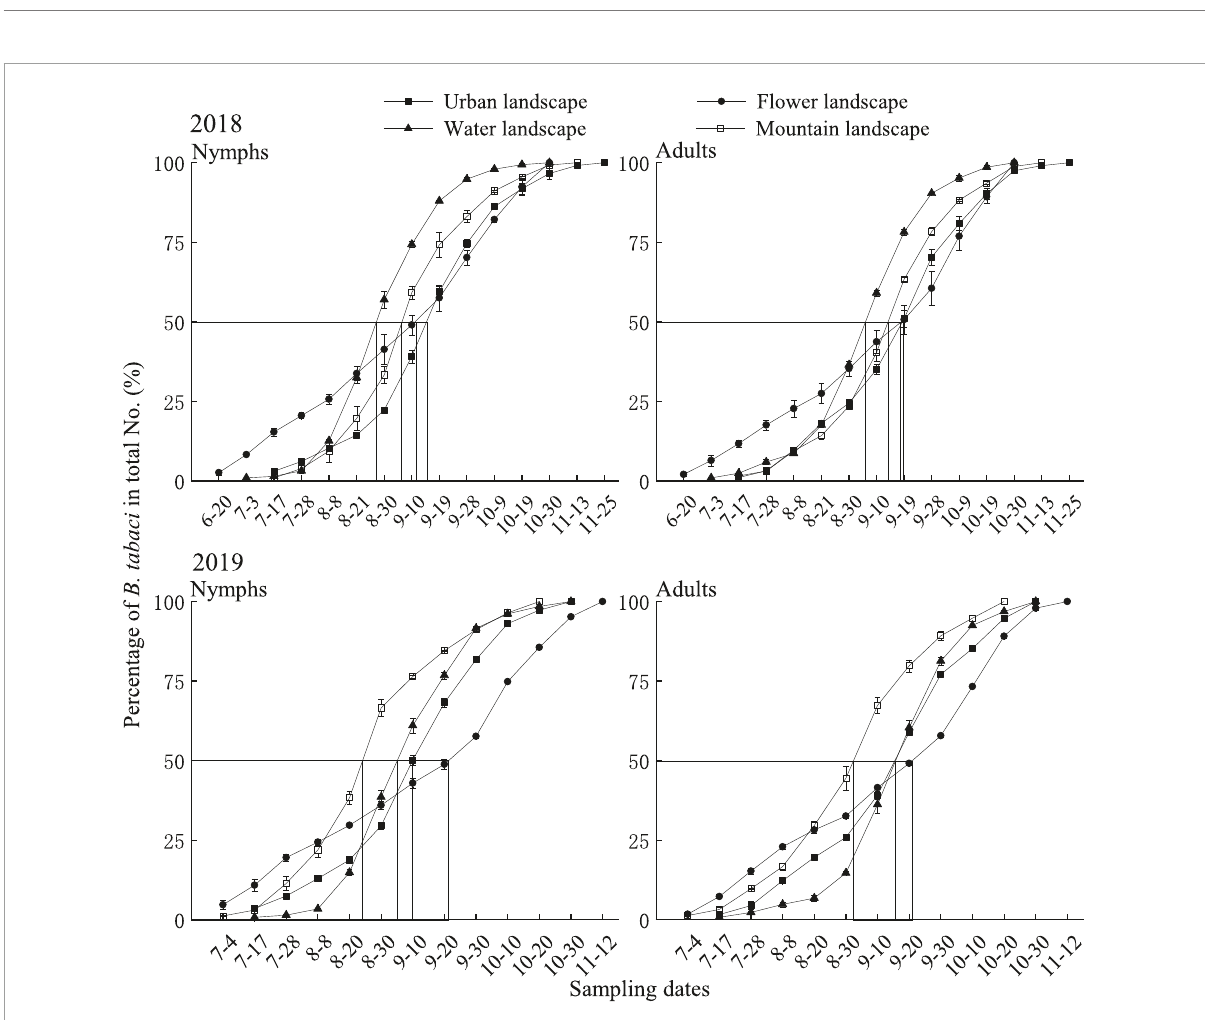
FIGURE1 Cumulative seasonal activity curves of Bemisia tabaci on summer tomato fields in different agricultural landscapes in Kunming city, Yunnan province, South China, in 2018 and 2019. Urban landscape: Tomato fields of an agricultural landscape dominated by the urban area, flower landscape: tomato fields of an agricultural landscape dominated by flowers, water landscape: tomato fields of an agricultural landscape dominated by water, and mountain landscape: tomato fields of an agricultural landscape dominated by mountains. The same is applicable to Figures 2 , 3